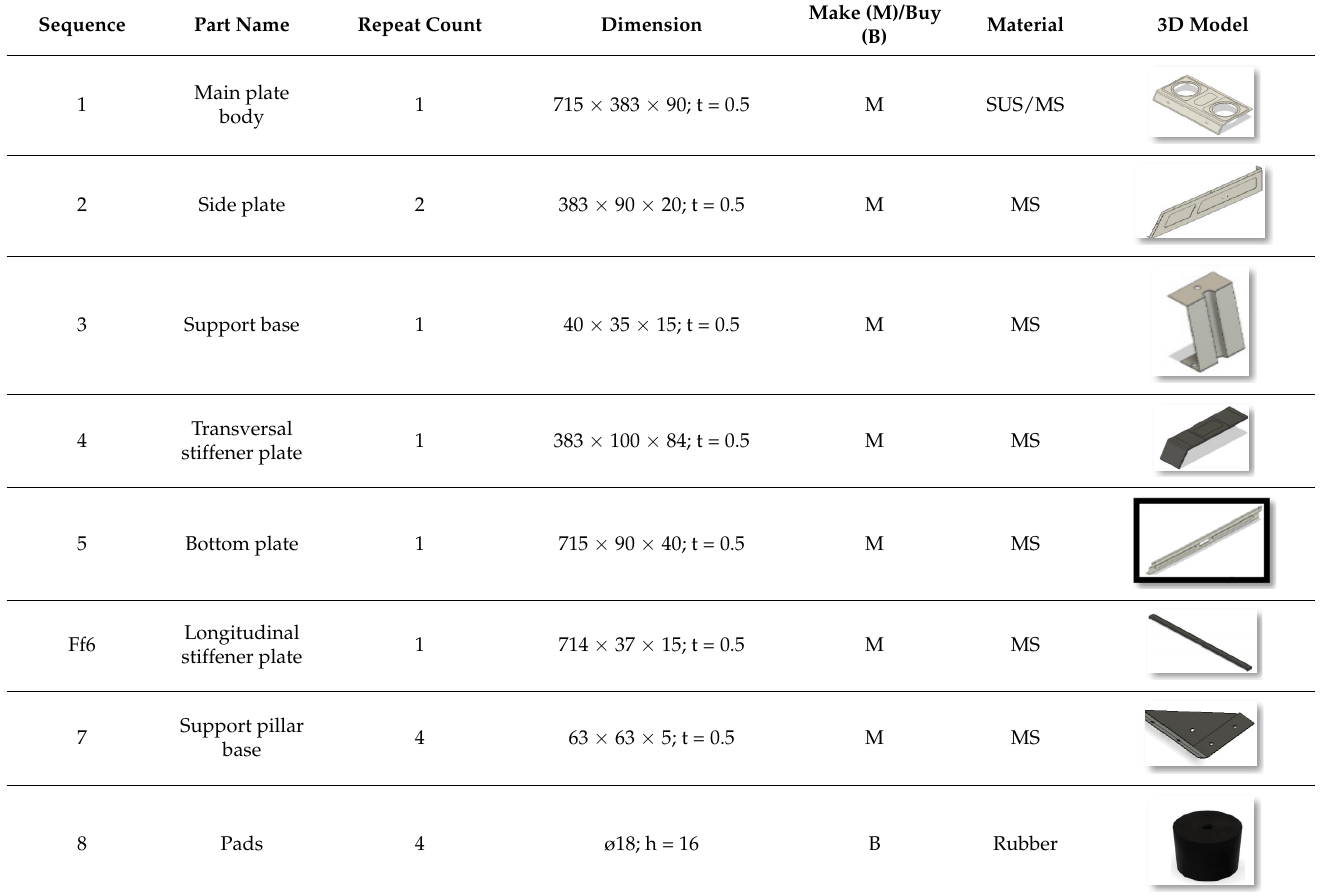
Figure 5. Assembled model of two burner gas stoves. Table 4. CAD modelling of gas stove parts (existing product).